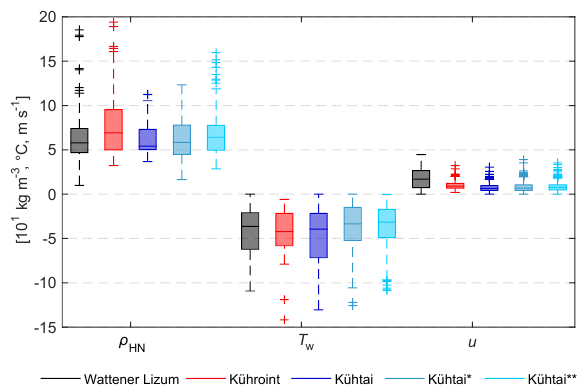
Figure 6. Box plots (median, 25 and 75% percentiles, 1.5 × interquartile ranges, outliers) of calculated new snow densi- ties ( ρ HN ) based on observations, wet bulb temperature ( T w ) and wind speed ( u ) for filtered snowfall events (Table 2) at three stations within period 2 (1 October 2011–1 October 2013) and at Kühtai sta- tion within period 3 (index ∗ , 1 October 1999–30 September 2011) and period 4 (index ∗∗ , 27 February 1987–30 September